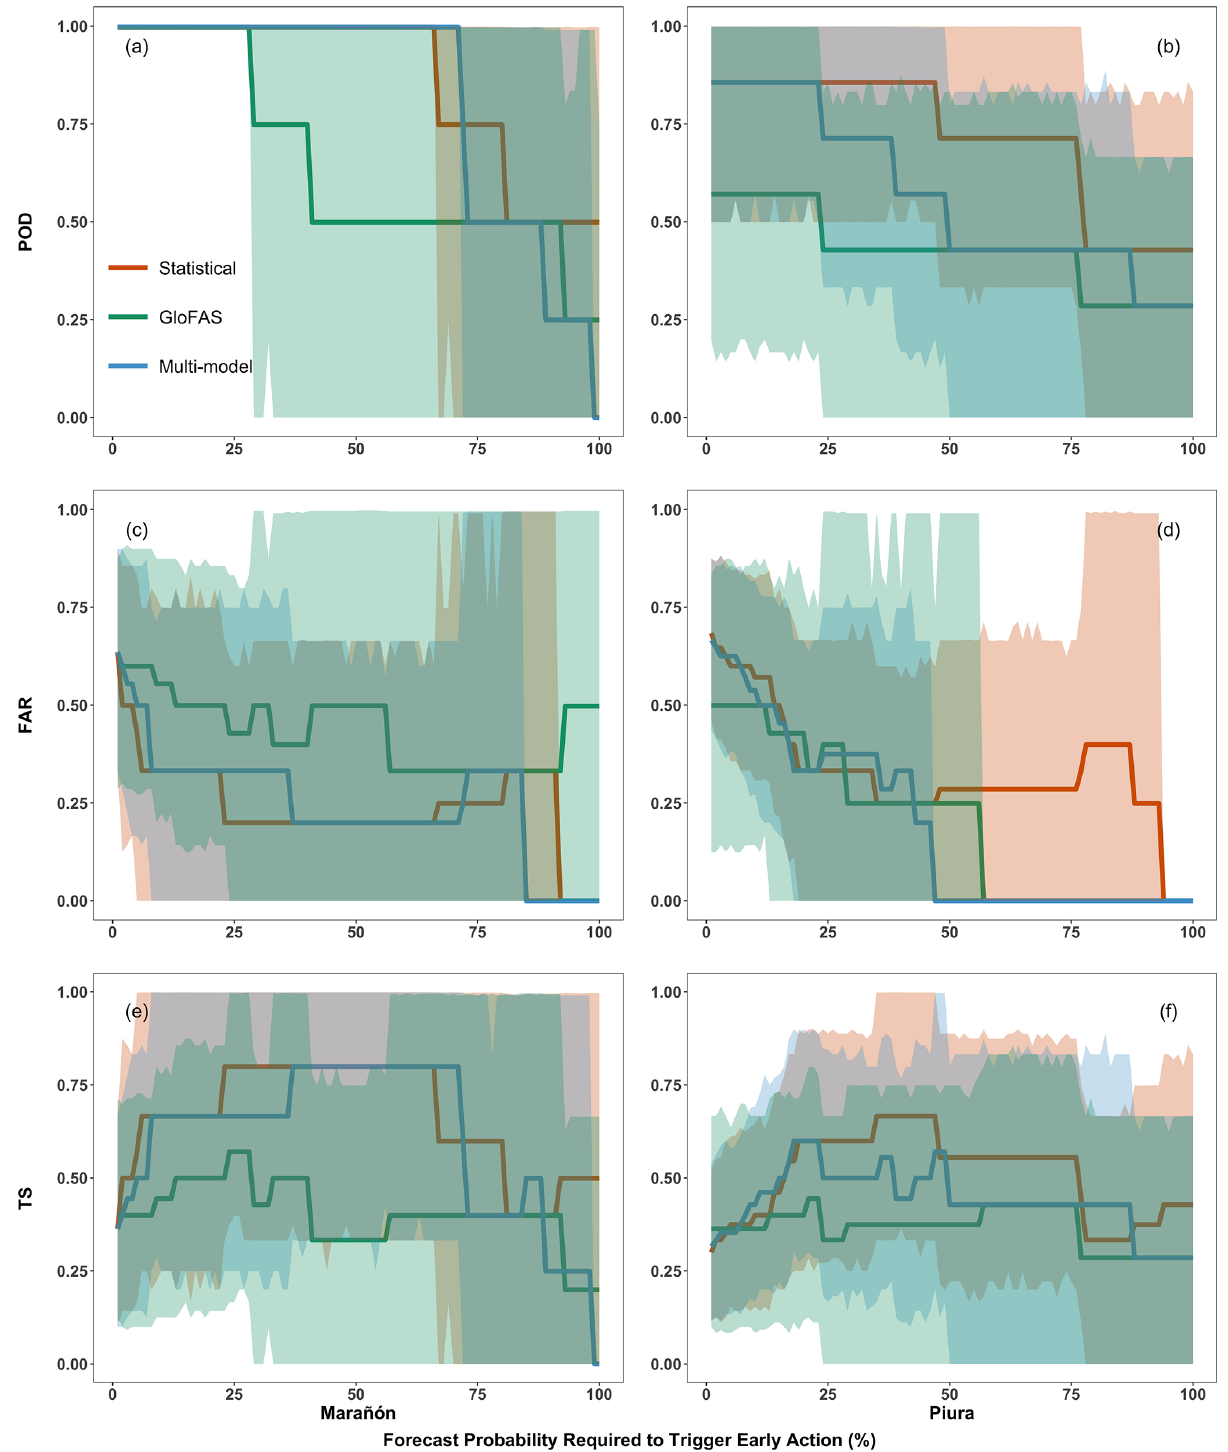
Figure 8. POD, FAR, and TS as a function of the threshold probability required to trigger early action for each location and forecast approach. Lines represent each metric calculated using hindcast data while ribbons represent sample size-associated uncertainty for each model at the 95% level, calculated via bootstrap resampling of the hindcast period ( n =